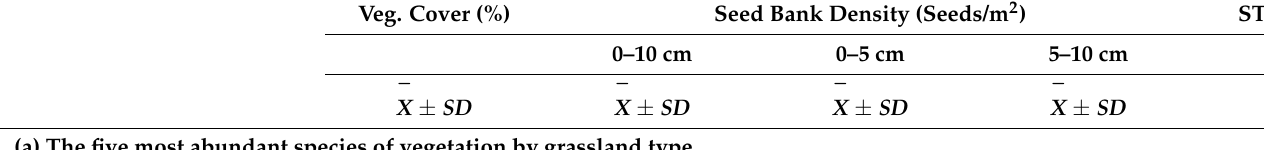
Table 3. Quantitative and qualitative properties of the five most abundant species of the above-ground vegetation ( a ) and the soil seed banks ( b ) in the three grassland types with different water